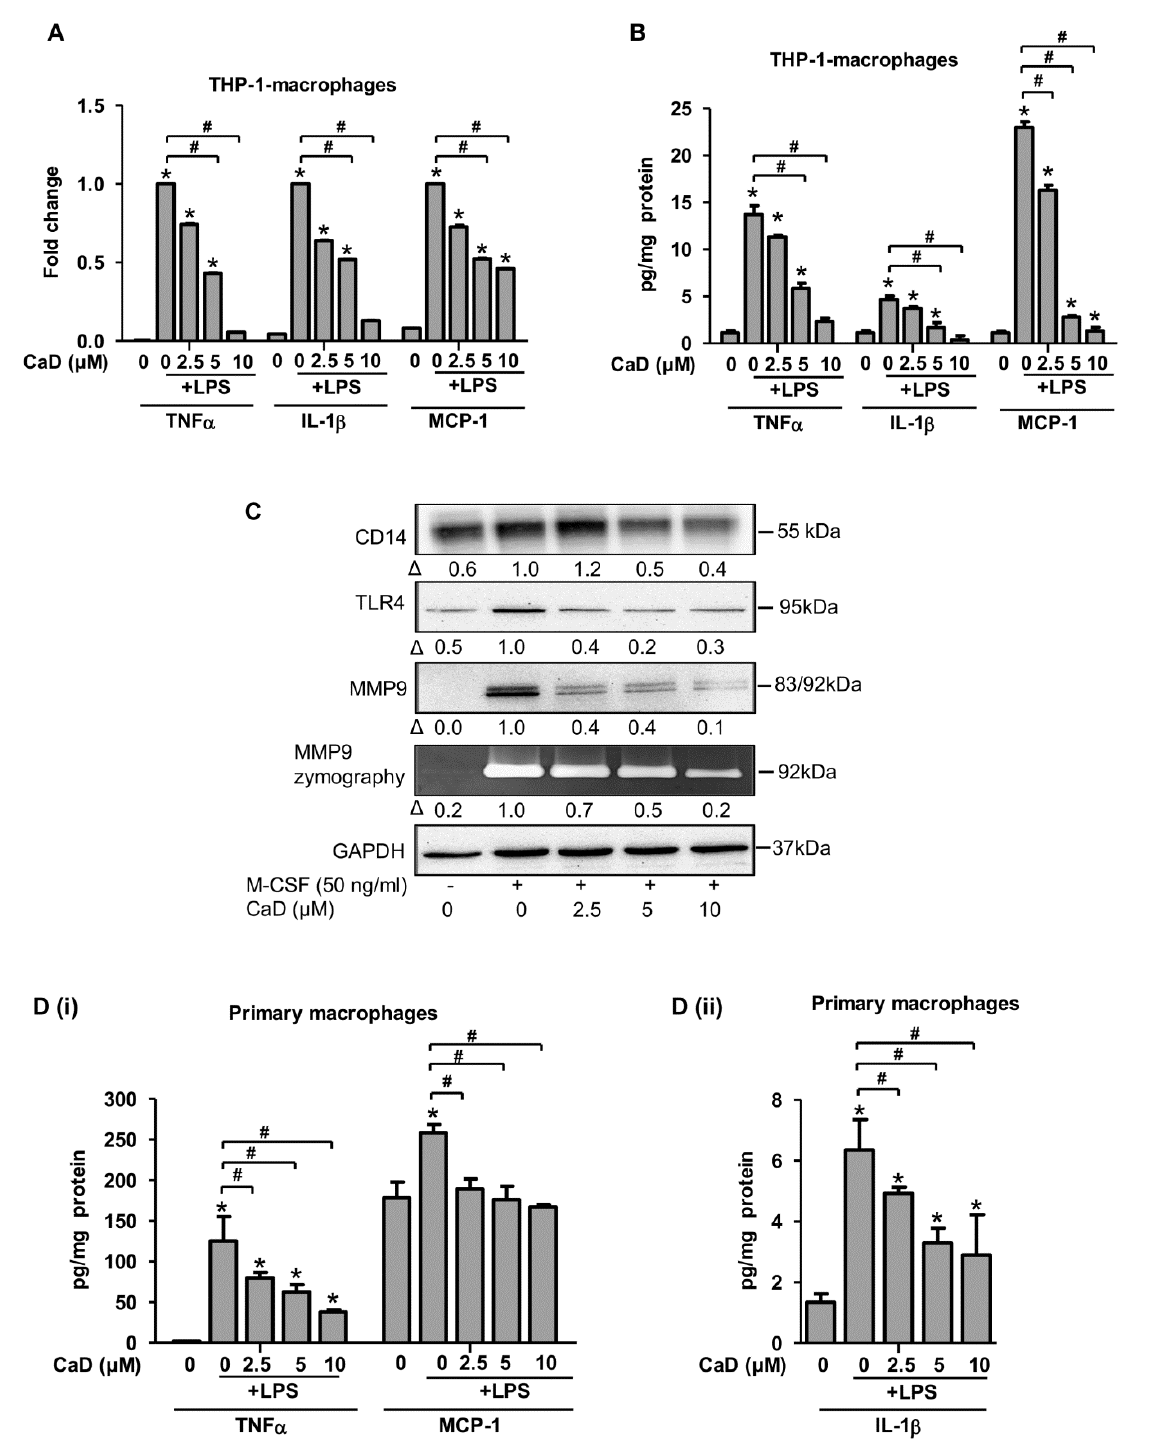
Figure 4. CaD inhibits primary human monocyte-to-macrophage differentiation and LPS-induced inflammation. Primary human monocytes were treated with various CaD concentrations (0–10 µ mol/L) for 1 h followed by M-CSF (50 ng/mL) treatment for 5 days ( A ). Protein levels and MMP9 activity were measured by Western blotting and gelatin zymography, respectively. THP-1 cells and primary human monocytes were differentiated into macrophages in the presence of various CaD concentrations (0–10 μ mol/L) for 48 h and 5 days, respectively ( B – D ). Macrophages were then stimulated with LPS (100 ng/mL) for 24 h. TNF α , IL1 β , and MCP-1 transcript levels ( B ) were measured by quantitative RT-PCR, and protein levels ( C , D ) in the conditioned media were measured by ELISA ( B ). Δ , fold-change normalized to PMA only ( n = 3, mean ± SEM. * p < 0.05 vs. no LPS, # p < 0.05 vs. LPS only, one-way ANOVA).